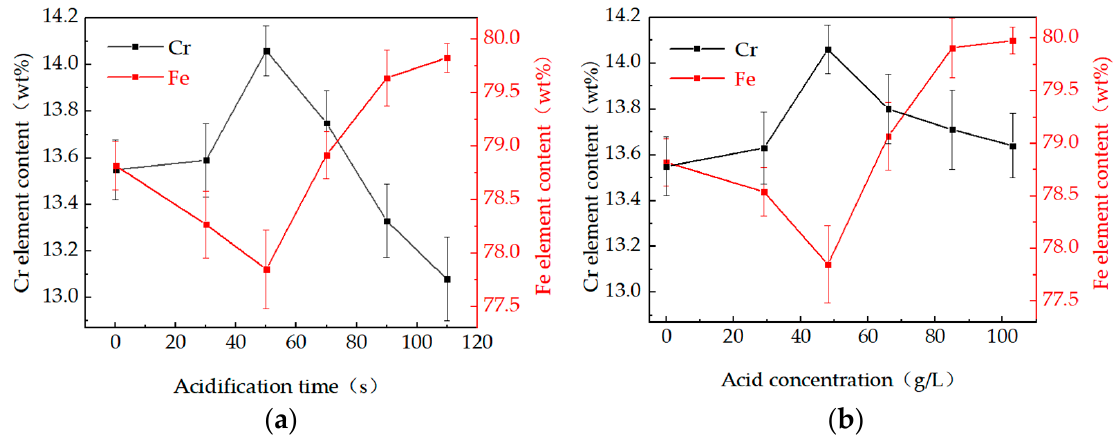
Figure 7. The content of Cr and Fe on Super 13Cr surface plotted as functions of the acidification parameters: ( a ) soaking duration; and ( b ) sulfuric acid concentration.